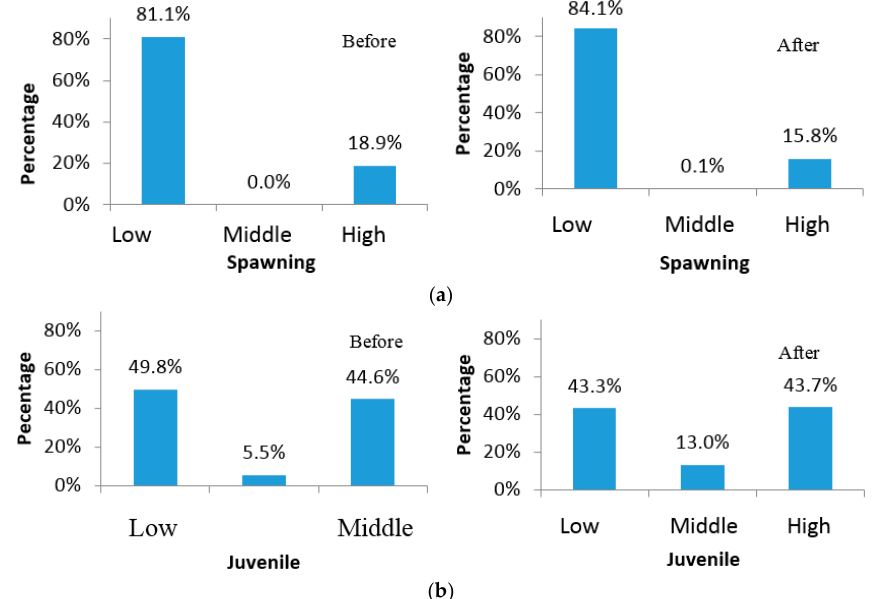
Figure 9. Before the HFE and after the HFE high, middle and low habitat suitability index distribution for spawning ( a ) and juvenile ( b ) rainbow trout.